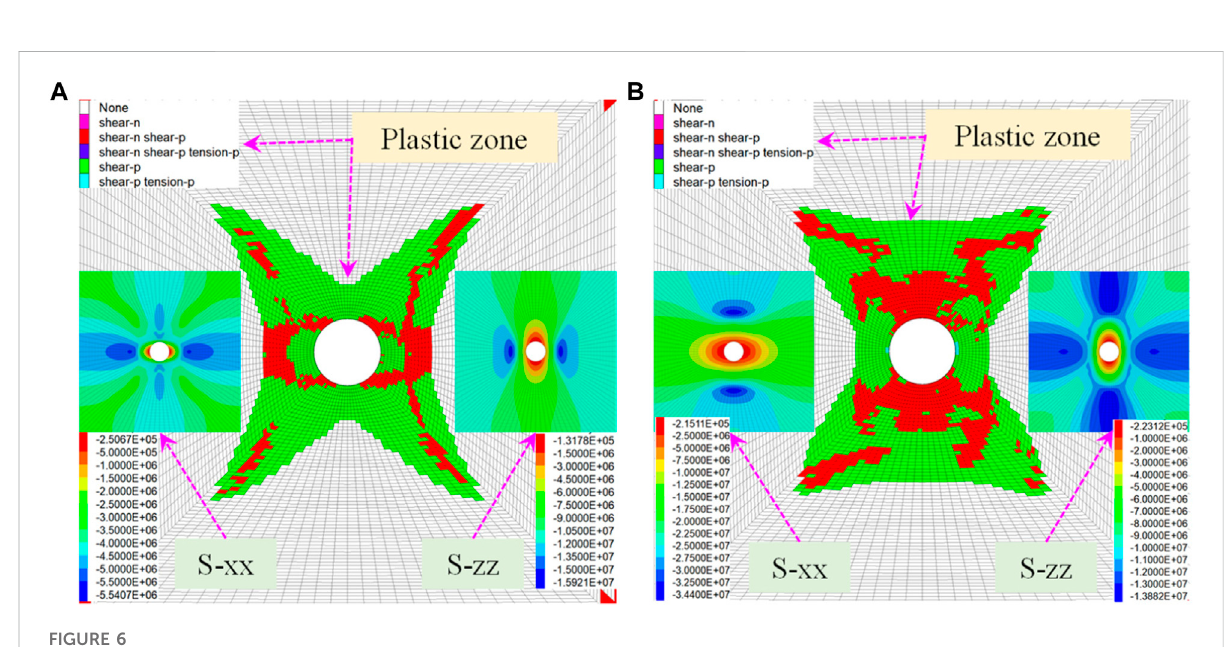
FIGURE 6 Critical range of the plastic zone in the nearby goaf